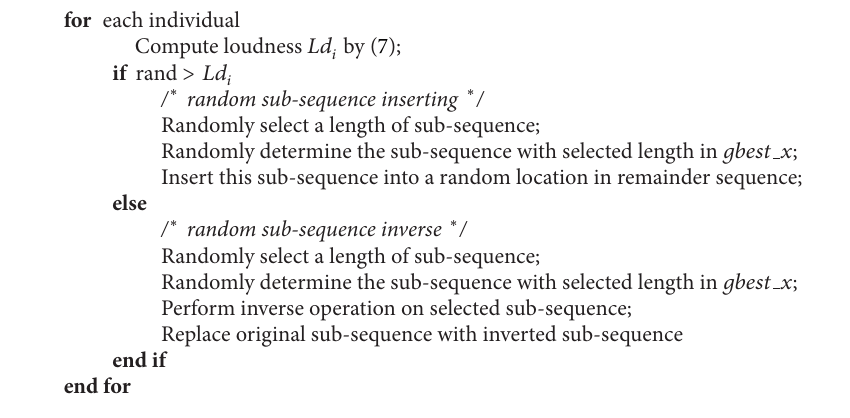
Algorithm 4: The pseudocode of loudness local operation.